Question: Draft a figure caption describing what is shown.
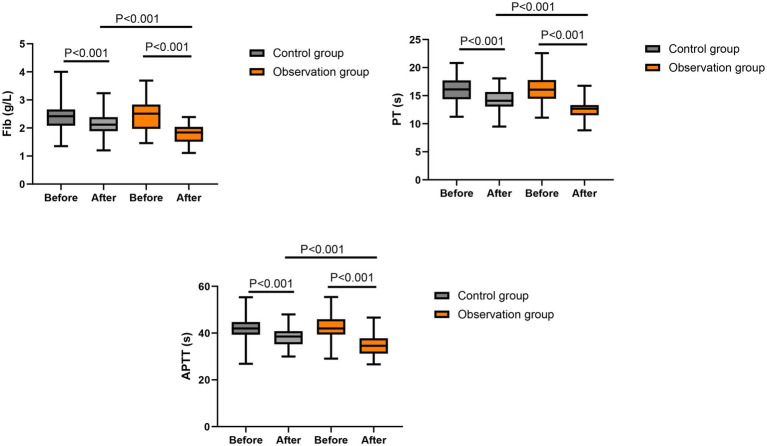
Answer: Coagulation-function indicators before and after treatment in the two groups. Data are presented as mean ± standard deviation.